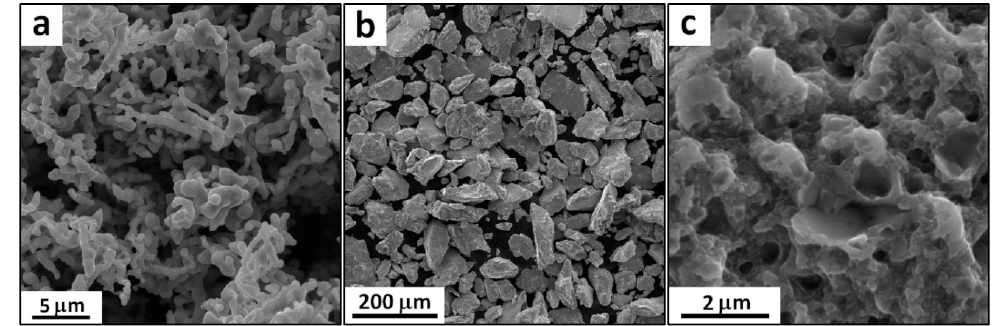
Figure 5. ( a ) Morphology of the conventional micro-crystalline powder; ( b ) morphology of the ball-milled powder; and ( c ) internal structure of the ball-milled powder.